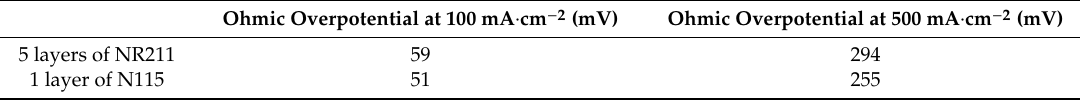
Table 3. Comparison of ohmic overpotential for a series of NR211 versus single-layer N115.